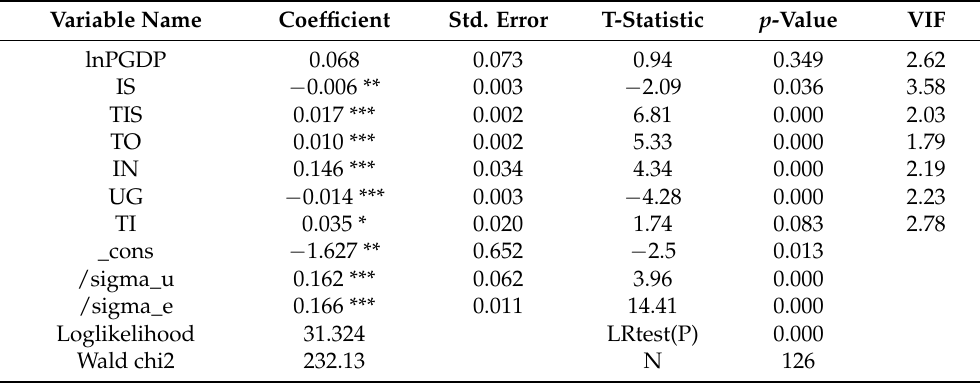
Table 4. Robustness test